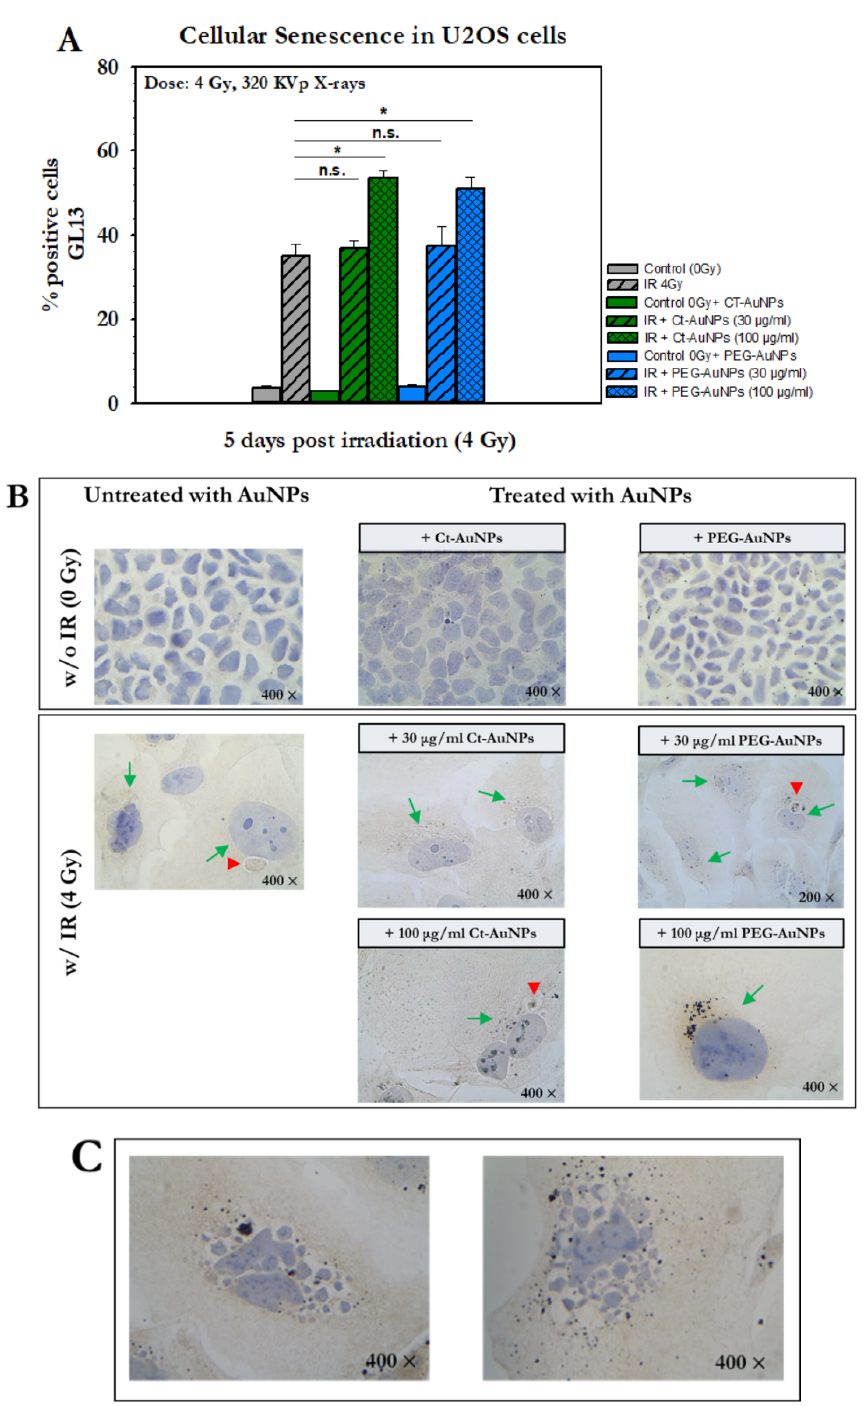
Figure 16. Identification of senescence in U2OS cells after treatment with AuNPs and exposure to 4 Gy, 320 KVp X-rays. ( A ) Histograms represent the mean levels of cellular senescence in each group. Statistical significance between irradiated cells with or without treatment with AuNPs was determined using Student t test: * p ≤ 0.05, n.s.: not significant. ( B ) Images represent each group with or without exposure to IR after or not the treatment with different concentrations of either 15 nm Ct-AuNPs or 5 nm PEG-AuNPs. Cells were incubated at 37 ◦ C for 5 days after radiation exposure. Green arrows indicate senescent cells and red arrows indicate perinuclear structures of GL13 staining. Original magnifications: 200×, 400×. ( C ) Indication of increased fragmented nuclei after exposure to 4 Gy X-rays and after staining with GL13. This phenotype was more prominent in cells treated with 100 μ g/mL PEG-AuNPs (5 nm) before exposure to ionizing radiation.